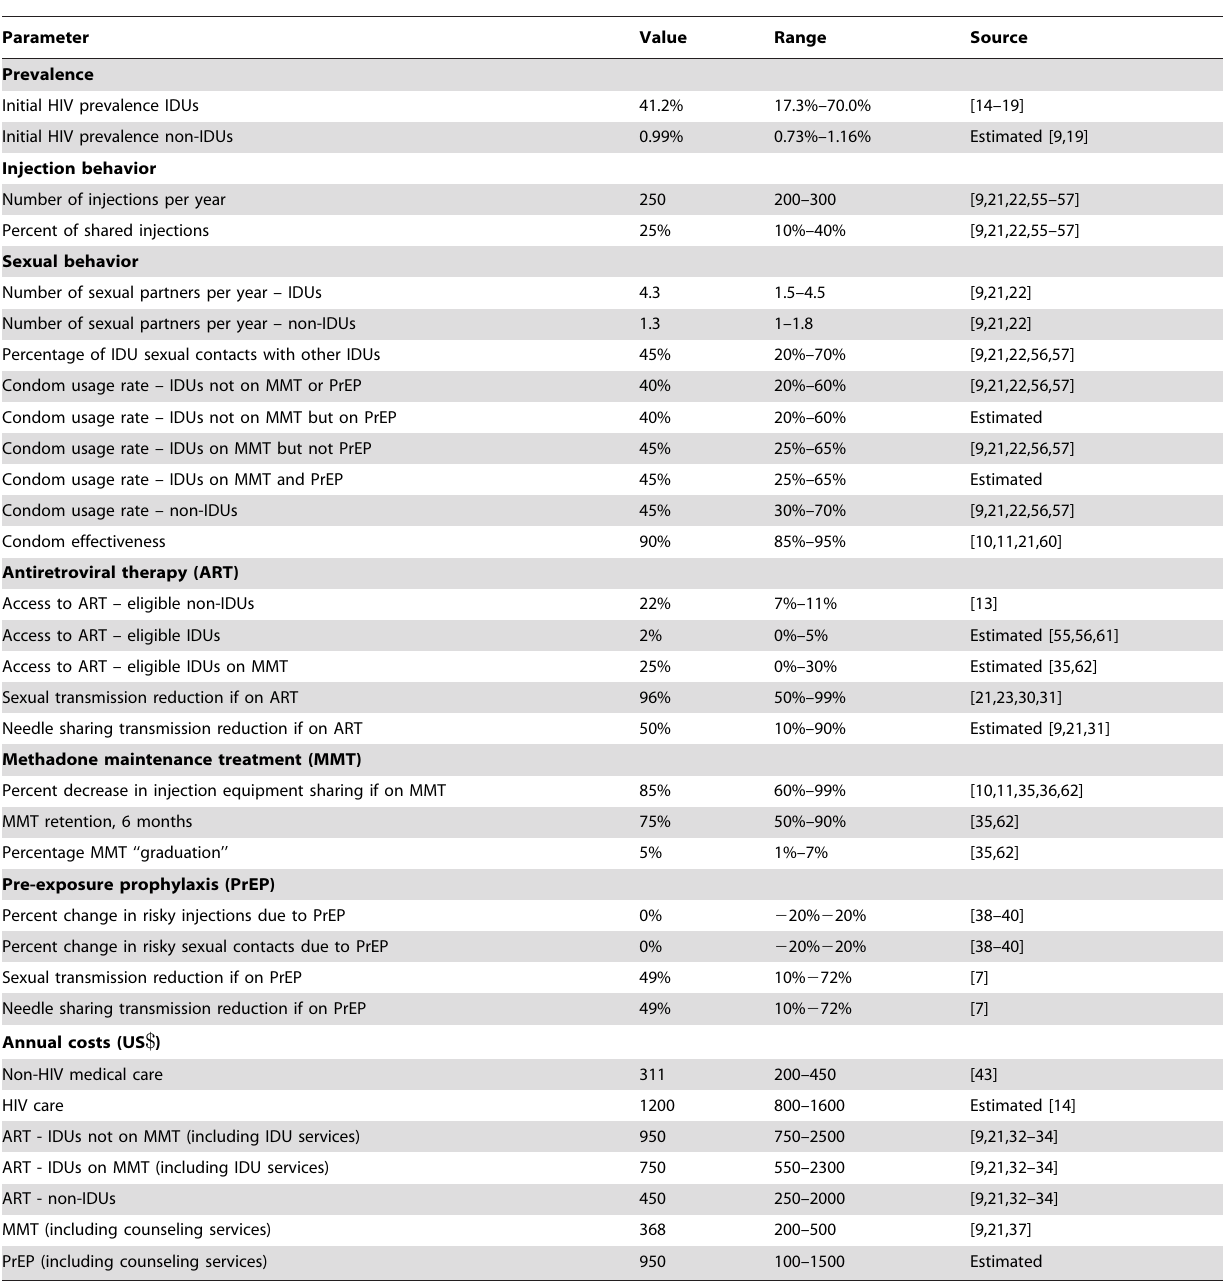
Table 1. Key parameter values, ranges, and